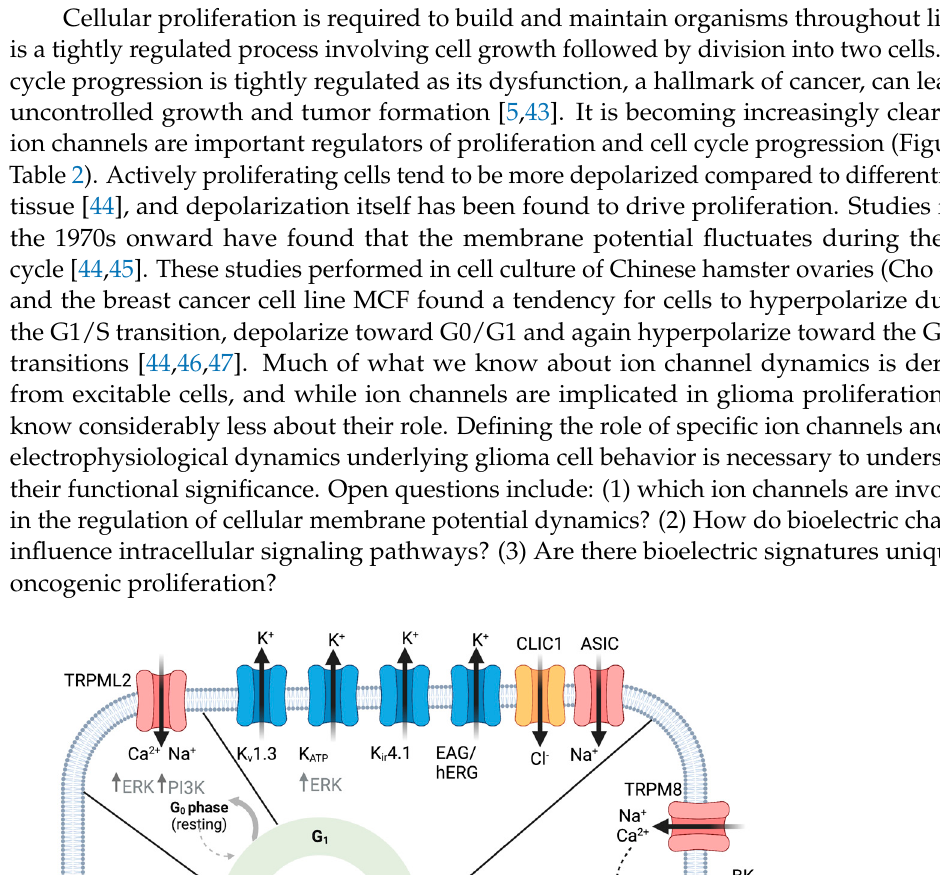
Table 2. Ion channel behaviors. This table summarizes cell behaviors of various ion channels: pro- liferation (clear), metastasis and invasion (yellow), metabolism (red), angiogenesis and tumor mi- croenvironment (TME) (blue), apoptosis, or seizure-related behavior (green). BBB, blood–brain bar- rier. “ ↑ ” indicates increased, “ ↓ ” represents decreased, “ → ” indicates, for example in G1 → S, cell cycle progression from G1 to S phase. GABR , Gamma-aminobutyric acid type A receptor subunits (mul- tiple).